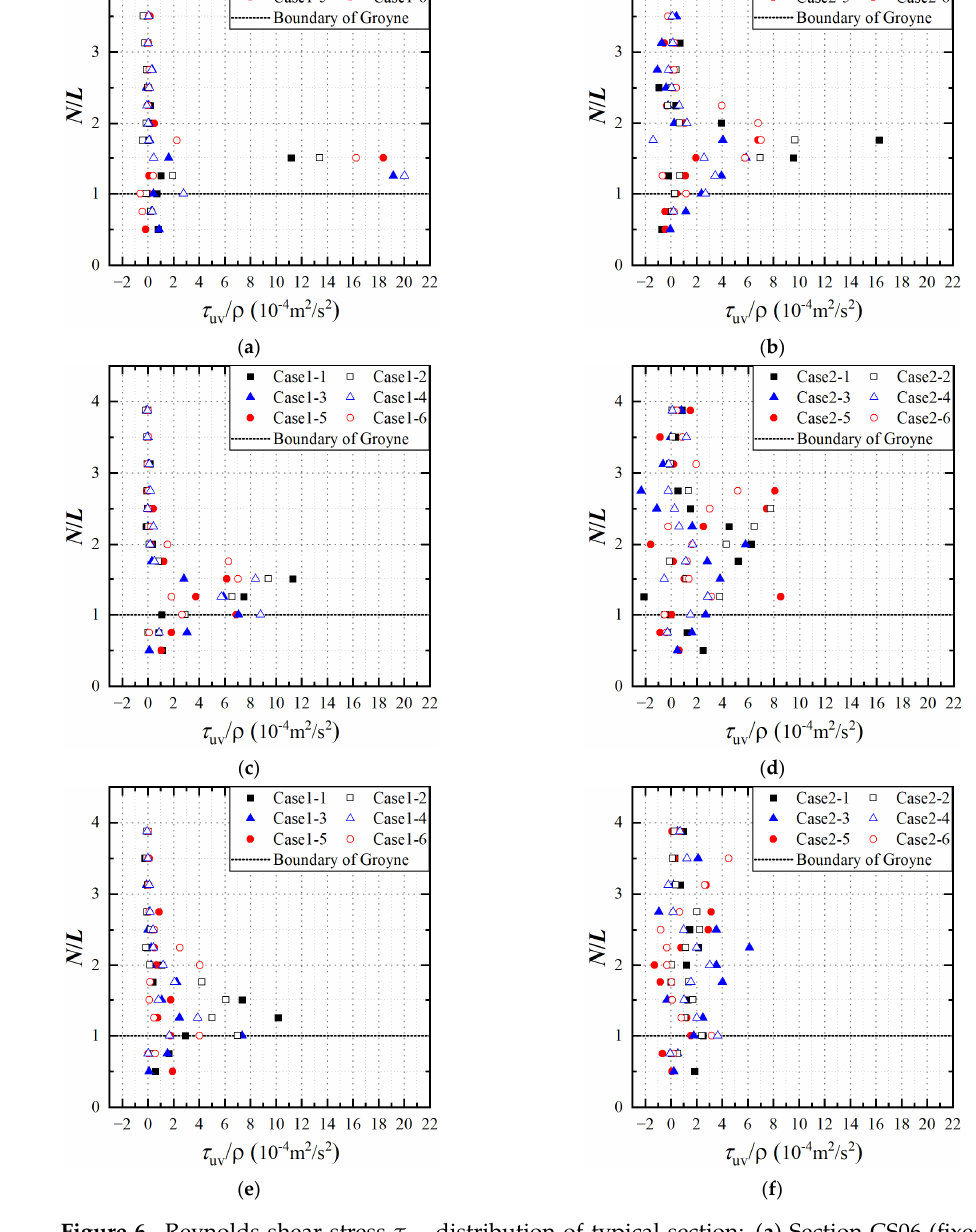
Figure 6. Reynolds shear stress τ uv distribution of typical section: ( a ) Section CS06 (fixed bed), ( b ) Section CS06 (mobile bed), ( c ) Section CS10 (fixed bed), ( d ) Section CS10 (mobile bed), ( e ) Section CS14 (fixed bed) and ( f ) Section CS14 (mobile bed).